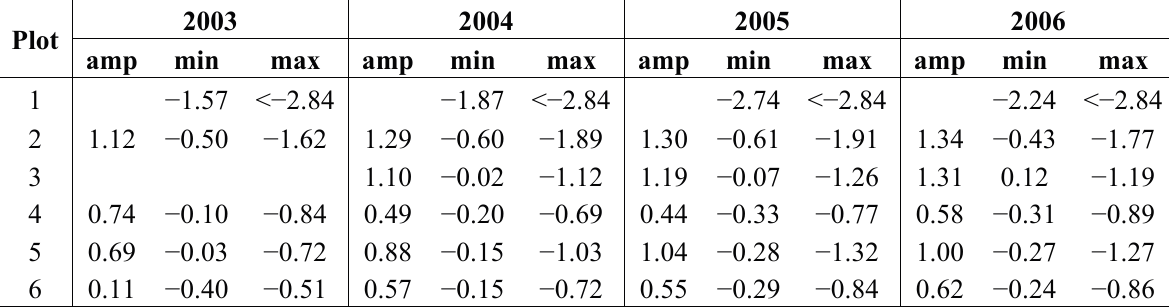
Figure 2. Time series of the groundwater levels in piezometers near the vegetation plots representative for ( a ) the drier (Plots 1–3, plots already emerged in 2003) and ( b ) wetter parts (Plots 4–6, plots still submerged in 2003) of the landfill. The dashed line indicates data of groundwater sampling disturbing the time series. The piezometer near Plot 1 was dry on a regular basis. Table 2. Amplitude, (amp), minimal (min) and maximal (max) water depth (m) of piezometers closest to the plots used for the monitoring of metal uptake in the